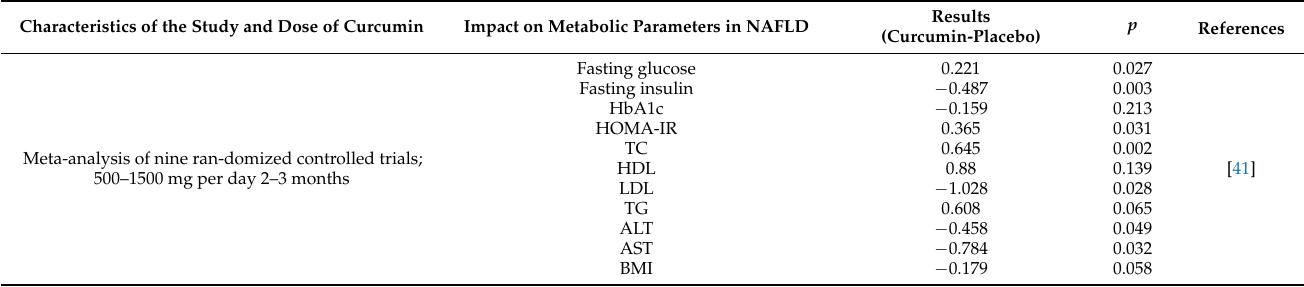
Table 3. The results of curcumin supplementation in nine randomized trials on metabolic parameters in NAFLD. Characteristics of the Study and Dose of Curcumin Impact on Metabolic Parameters in NAFLD Results p References